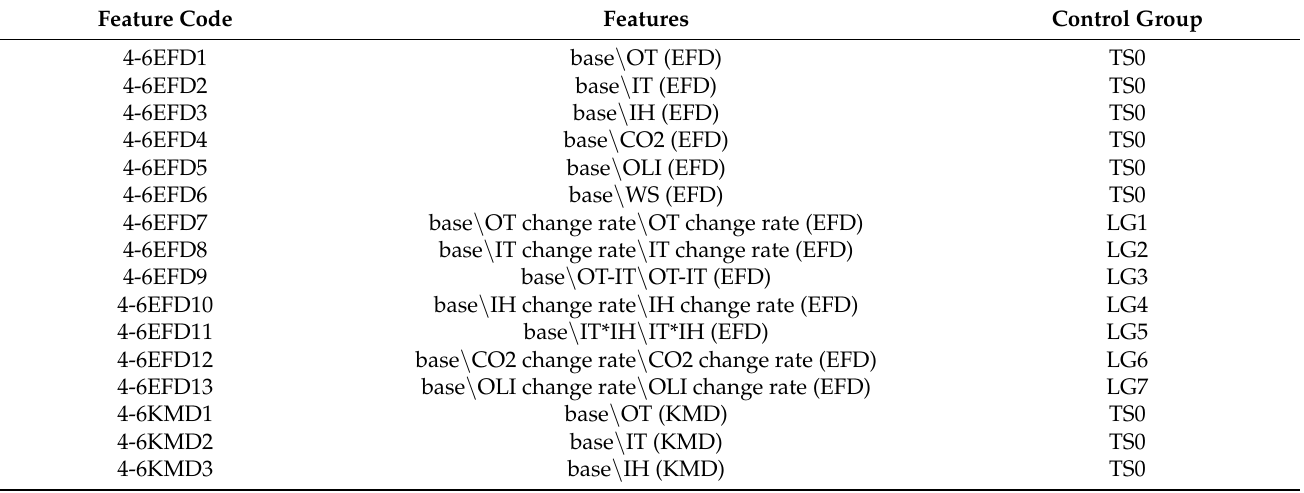
Table 7. Binning feature